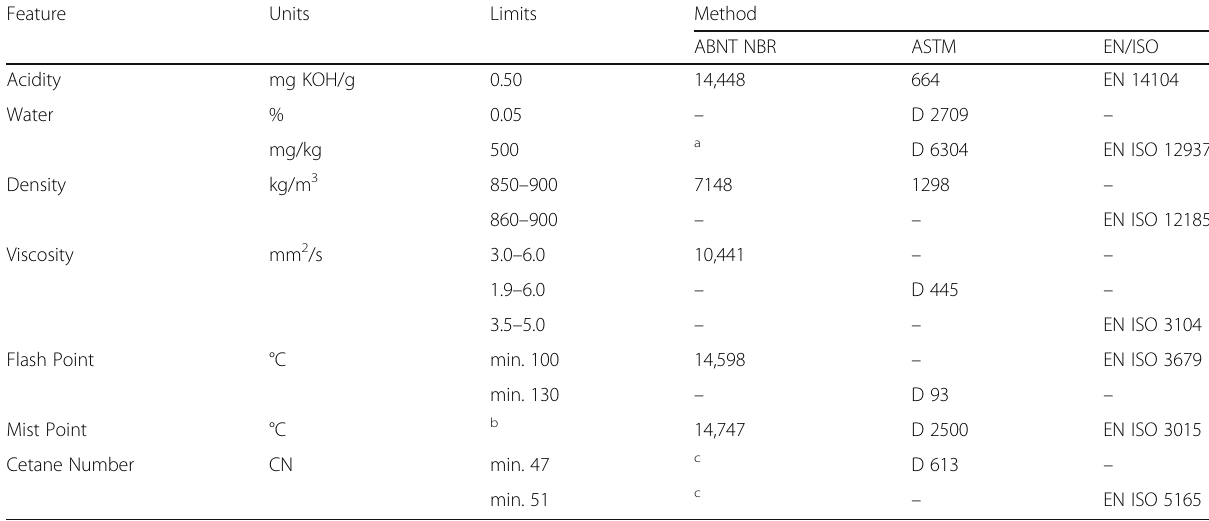
Table 4 Biodiesel characteristics in different world regulations